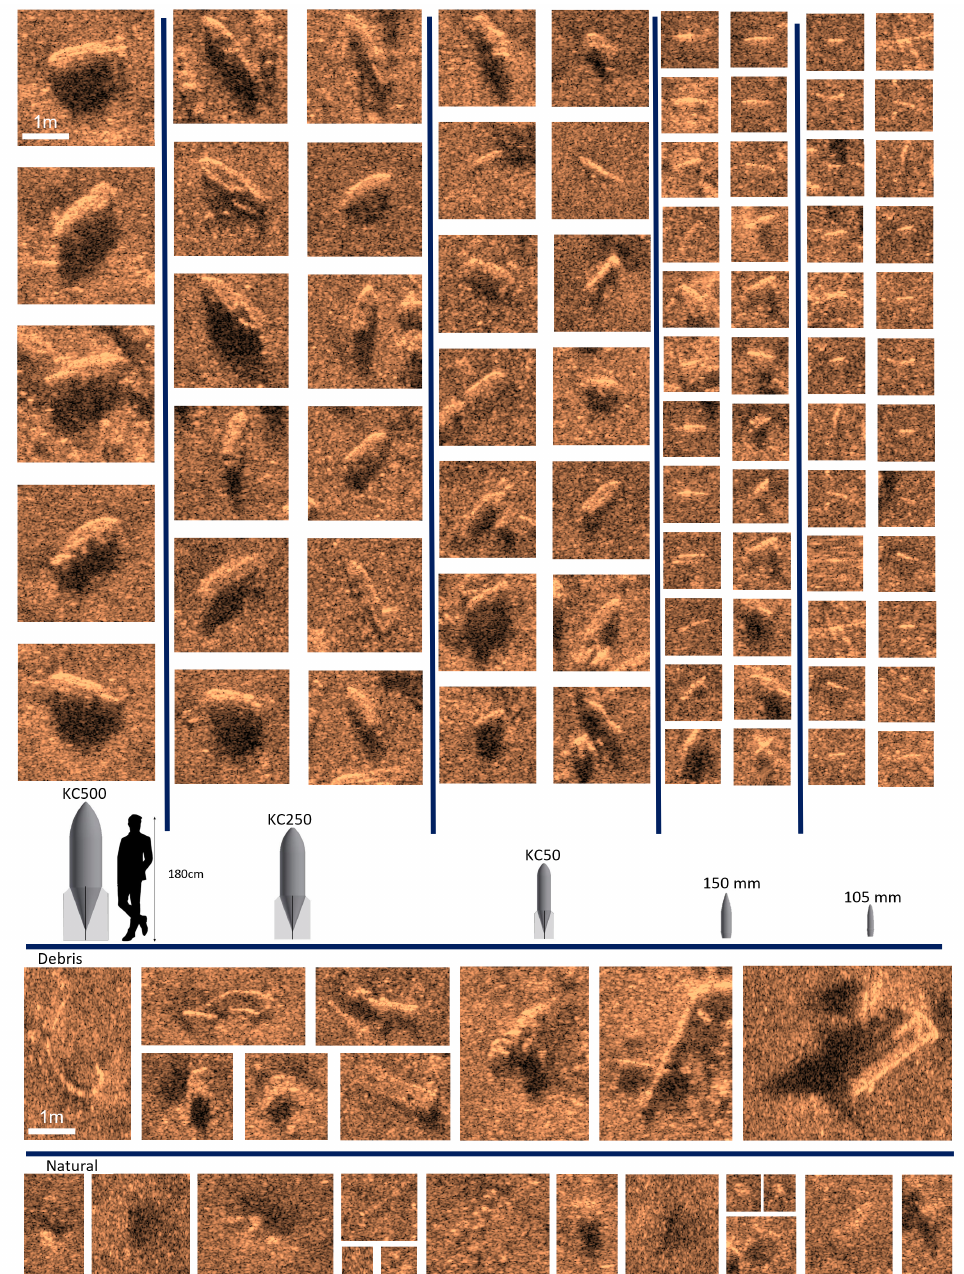
Figure 1. Objects (dangerous and harmless) found at Skagerrak, with examples from synthetic aperture sonar (all SAS images are at the same scale). Historic photos of UXOs before dumping at Skagerrak can be found in